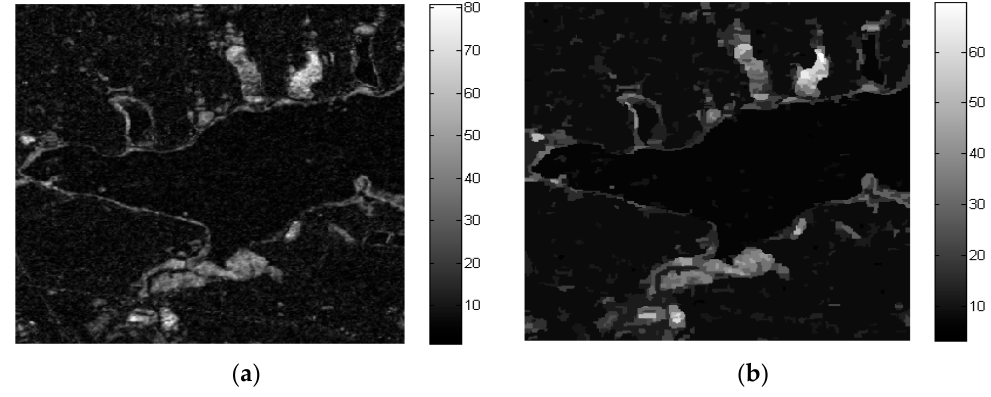
Figure 5. ( a ) The difference image based on omnibus test statistic; ( b ) The difference image after GSRM.